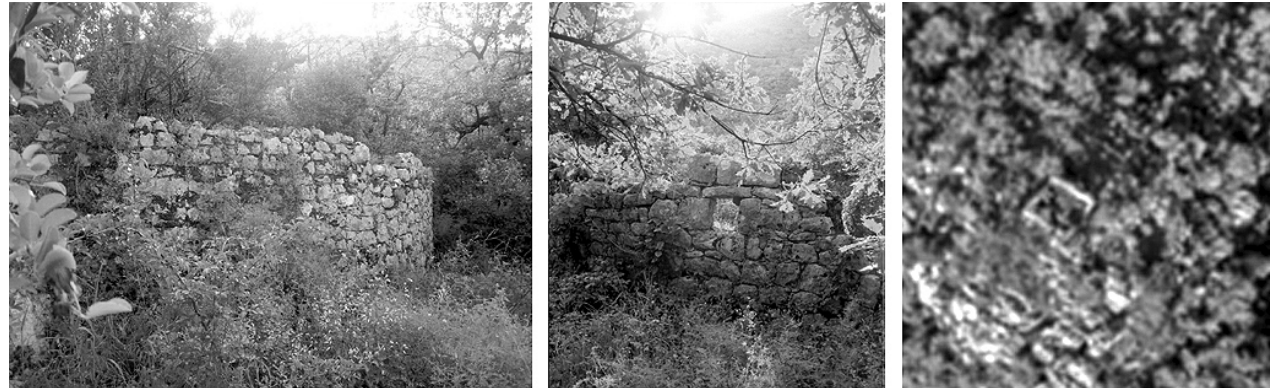
Figure 5. Divan Grad (Photo: D. Starcevic) .